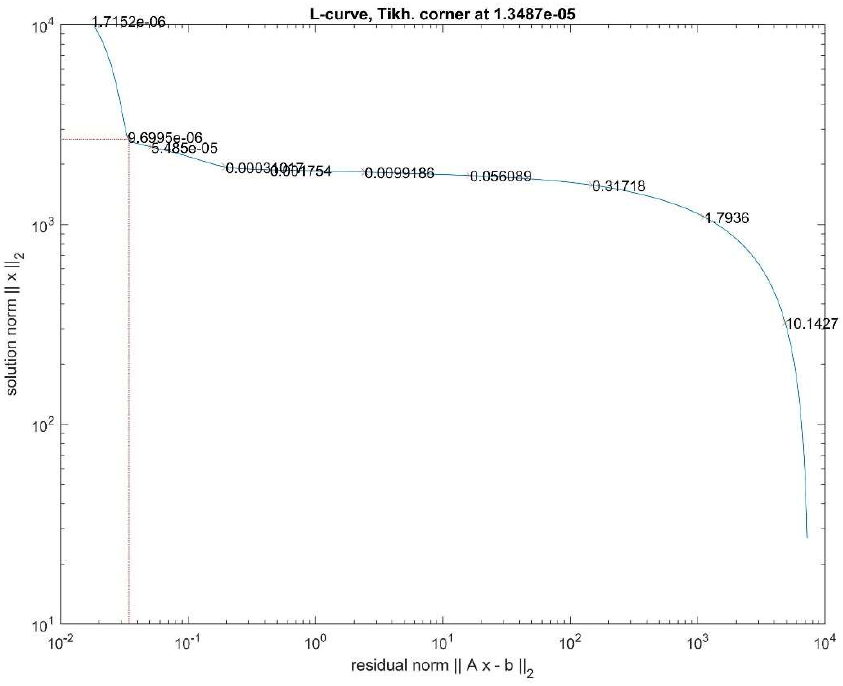
Figure 6. The L-Curve method for determining the smoothing parameter.